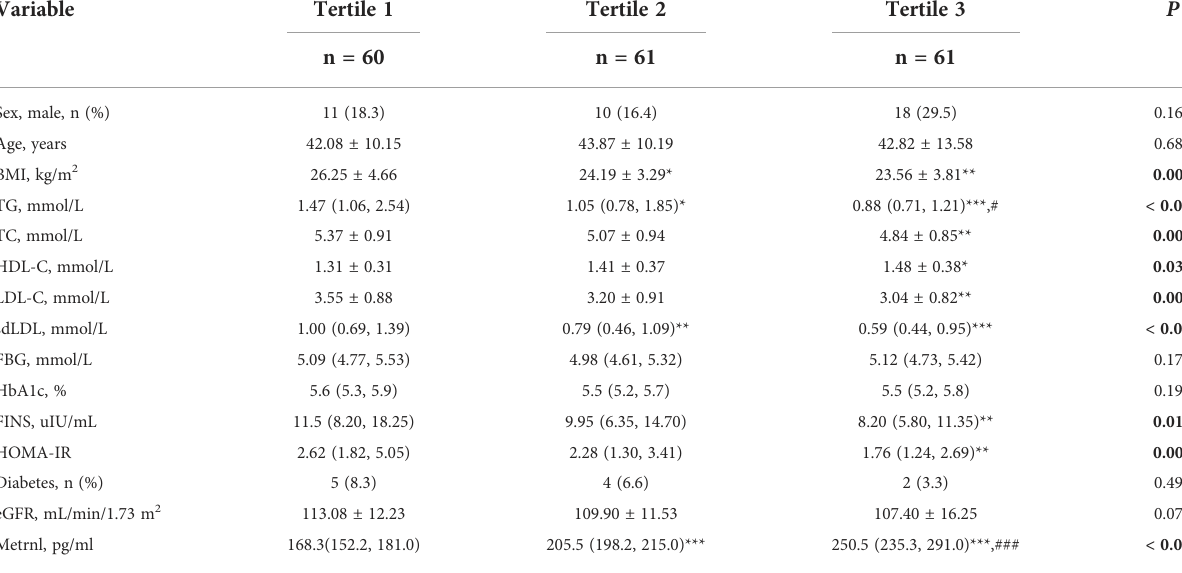
TABLE 2 Clinical characteristics of the study population according to the tertiles of serum Mternl levels.